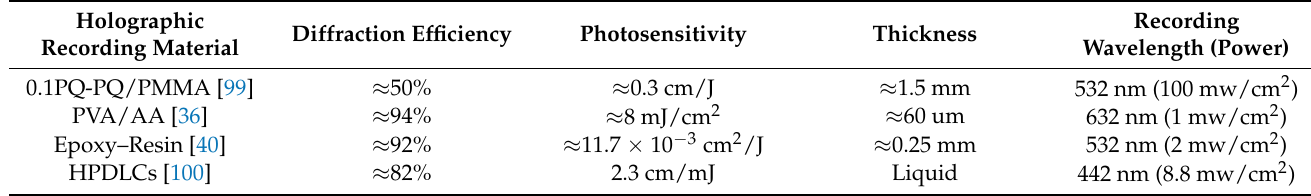
Table 1. Characteristic parameters of several holographic recording